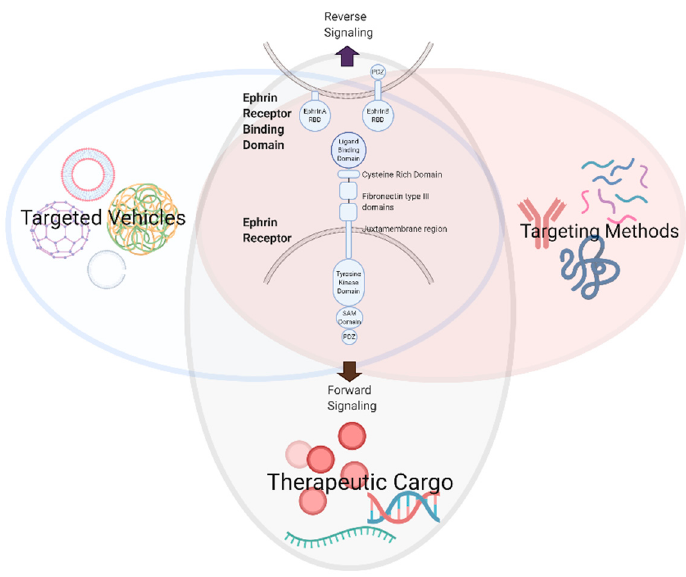
Figure 2. Development of therapeutic modalities to modulate Eph / ephrin signaling (created with BioRender.com).